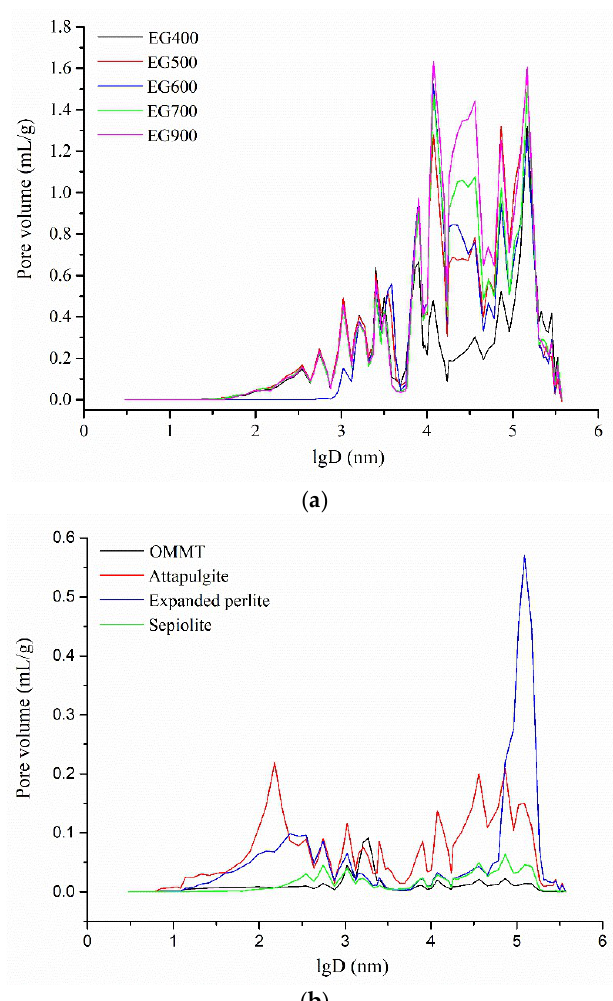
Figure 3. Pore size distribution of ( a ) EG treated at different temperatures, ( b ) other inorganic skeletons.